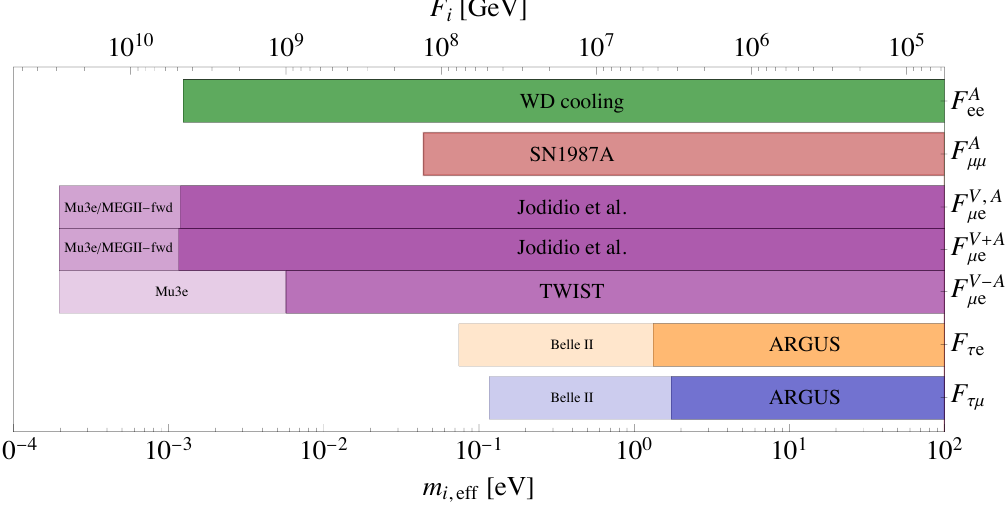
Figure 3 . Current bounds and future projections for different couplings F i of an effectively massless ALP, also reported in table 1. On the lower axis we indicate the corresponding values for the effective axion mass defined by m = 4 . 7 eV × 10 6 GeV /F i, eff i